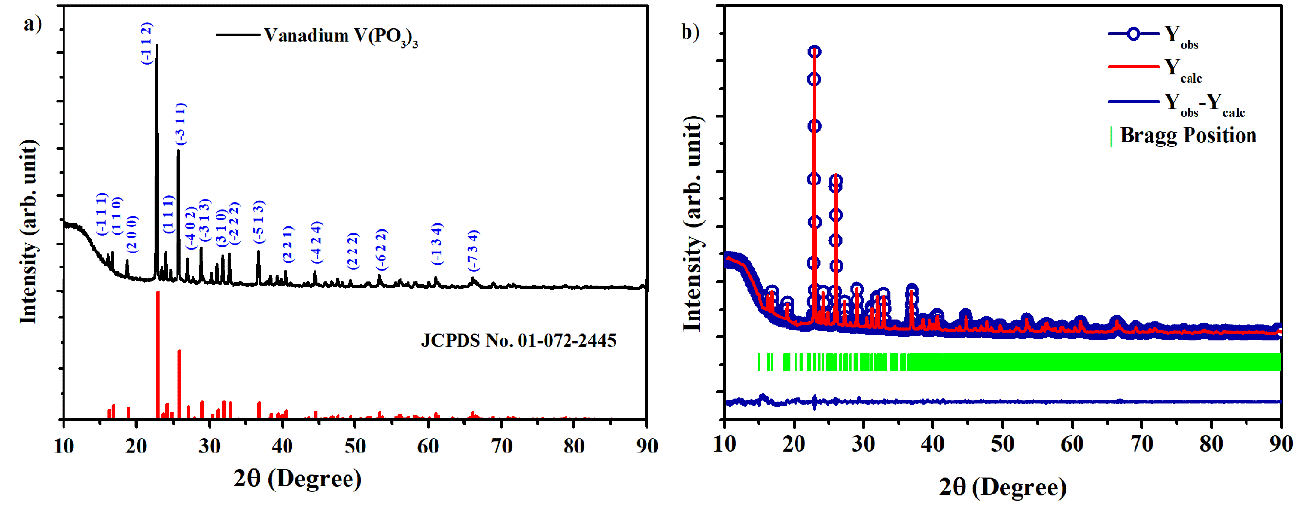
Figure 4. ( a ) XRD pattern and ( b ) Rietveld refinement fitting of vanadium(III) tris(metaphosphate).